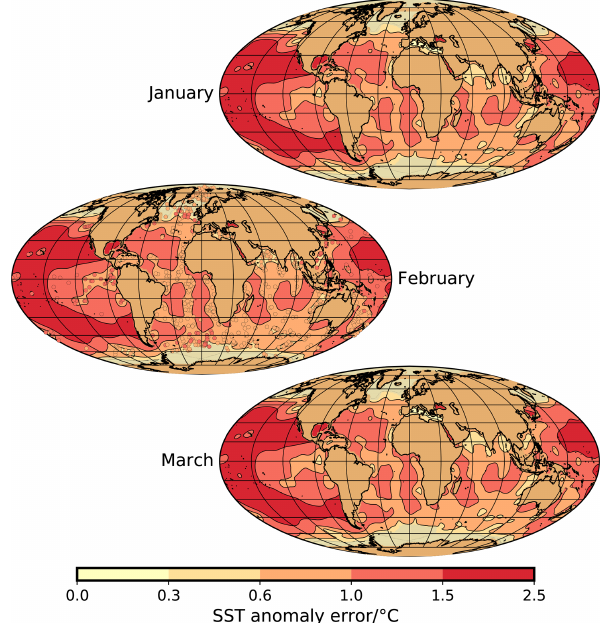
Figure A3. Uncertainty of NSST anomaly (contour map) and sea- ice extent (yellow–brownish areas close to Antarctica and in the Arctic; see Fig. A2) for January, February, and March. For February, we also show the error of the reconstruction at the sediment core locations as estimated by the MARGO Project Members